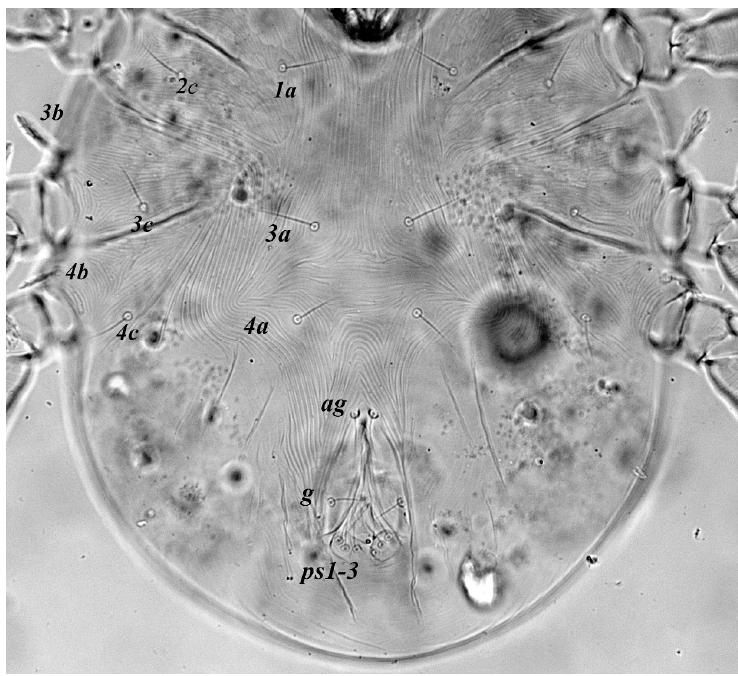
Figure 26. Camerobia southcotti . Female. Venter. Insects 2022 , 13 , x FOR PEER REVIEW